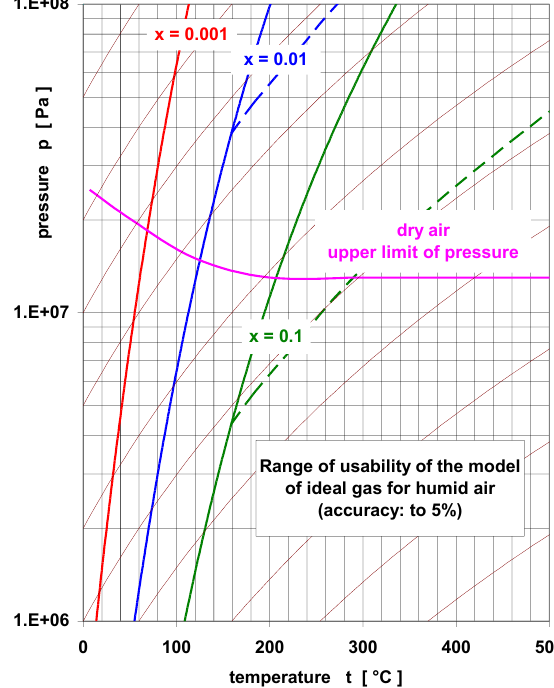
Fig. 7c. Area of usability of the ideal gas model for the calculation of properties of components of moist air at the required accuracy of the calculation to %5 for specific moisture x of 1.0 , 01.0 and 001.0   kg/kg DAV